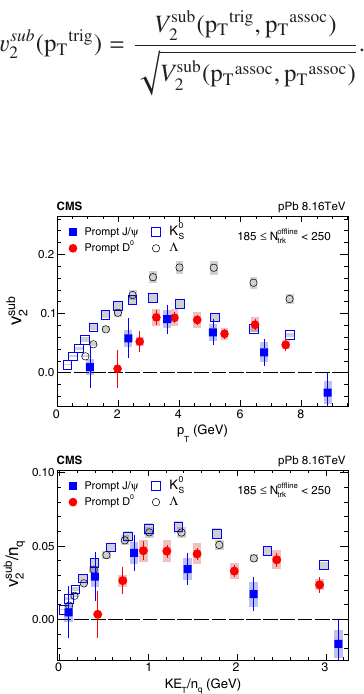
values for prompt J /ψ mesons at forward rapidities (1 . 4 < 2 and Λ hadrons and prompt D 0 mesons at midrapidity ( S < 250 where a low-multiplicity range with N o ffl ine N o ffl ine trk ≤